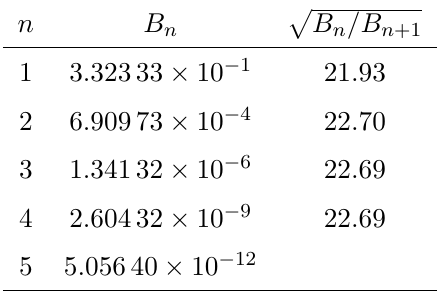
Table 1 . Binding energies of the five deepest states for Λ = 10 4 and H 0 (Λ) = 0 in the unitary limit.